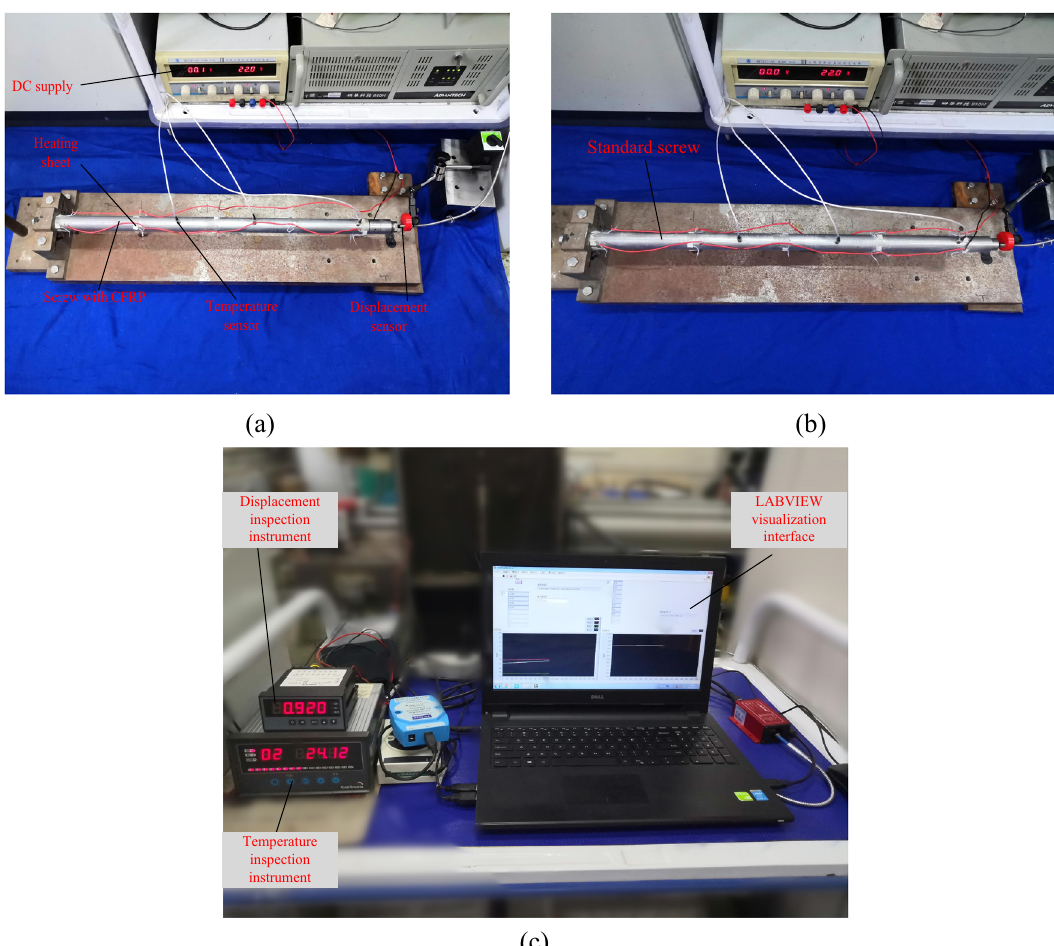
Figure 7: Experimental setup: ( a ) ball screw based on inner - embedded CFRP; ( b ) standard ball screw; ( c ) experimental data visualization interface.